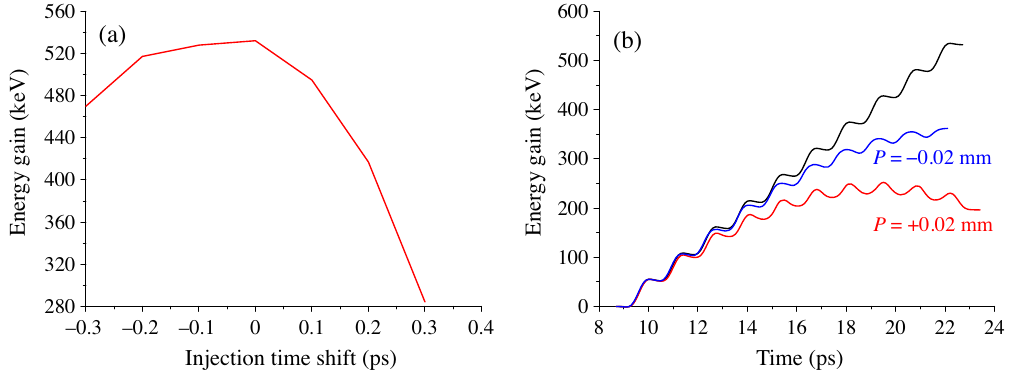
FIG. 12. Parameter optimization scans. (a) Energy gain as a function of injection time. (b) Energy gain as a function of structure periodicity.